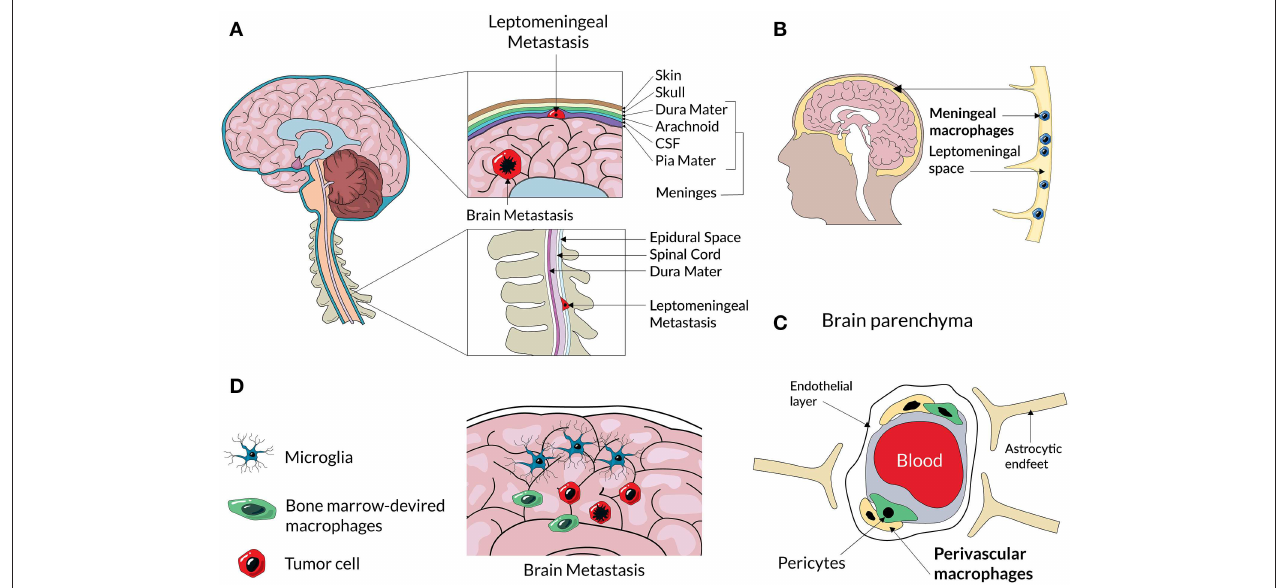
FIGURE 2 | A scheme representing an anatomical location of different CNS macrophage populations and CNS metastases. Cancer cells from primary tumors enter to the brain and cerebrospinal fluid (CSF) and can form secondary tumors within the brain parenchyma, or and spread to the membranes of leptomeninges surrounding the brain and spine (A) . Non-parenchymal macrophages located at the meninges (B) and perivascular spaces (C) can assist extravasation and spread of metastatic cancer cells. Metastatic lesions in the brain parenchyma consist of resident microglia and infiltrating BM-derived macrophages (D) that create a metastatic